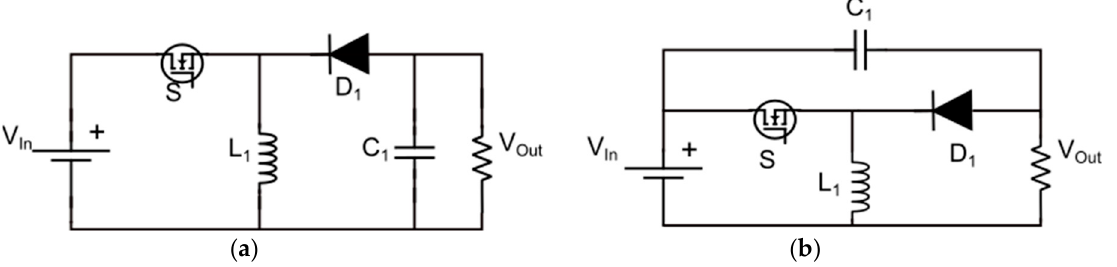
Figure 3. Conventional buck-boost topology ( a ). Continuous input current buck-boost converter (CIbB) ( b ).